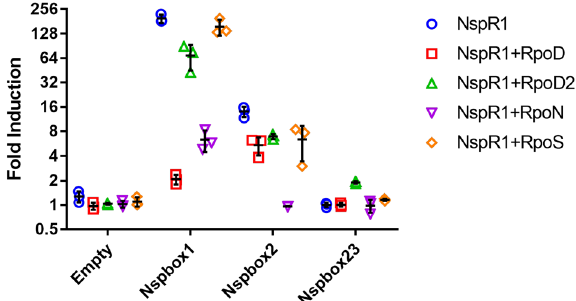
Fig. 4 Regulation of NspR1 on the predicted lux-box containing promoters with and without the co-expression of Nitrospira sigma factors. The screening was performed in E. coli TOP10 transformed with pPROBE-gfp(ASV) containing the predicted lux- box containing promoters (Nspbox) and pUCP22-NspR1 or pUCP22- NspR1 carrying the Nitrospira sigma factor gene. Relative fold induction was calculated by measuring the fold induction of GFP signals of the induced sample (added with 1 mM C8-HSL) to uninduced control (added with DMSO). Data are presented as mean ± SD.